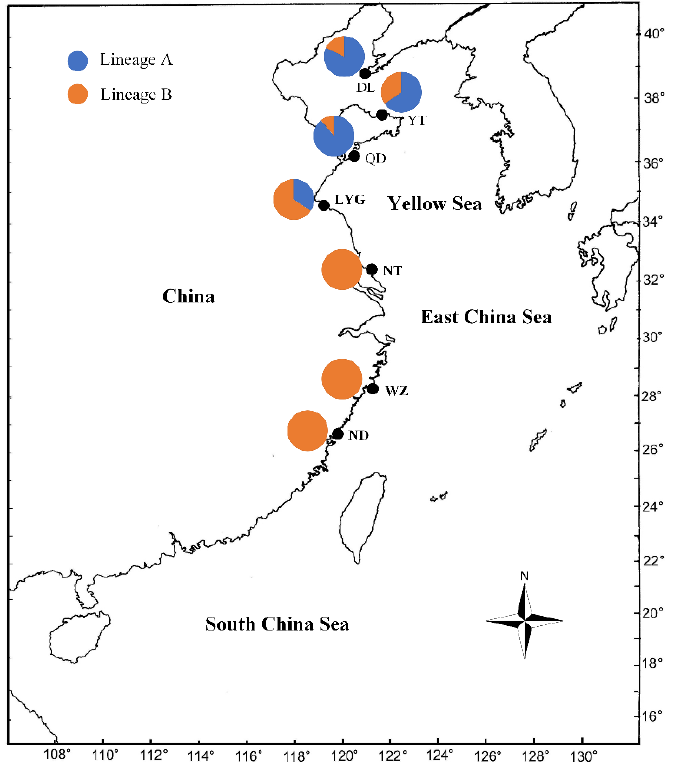
Figure 1. The sampling sites of L. ( N. ) beka and the distribution frequencies of Lineage A and Lineage B of mitochondrial DNA-based results (see below) in 7 localities. (Note: DL: Dalian; YT: Yantai; QD: Qingdao; LYG: Lianyungang; NT: Nantong; WZ: Wenzhou; and ND: Ningde. The blue in the pie chart represents Lineage A, and the orange represents Lineage B).